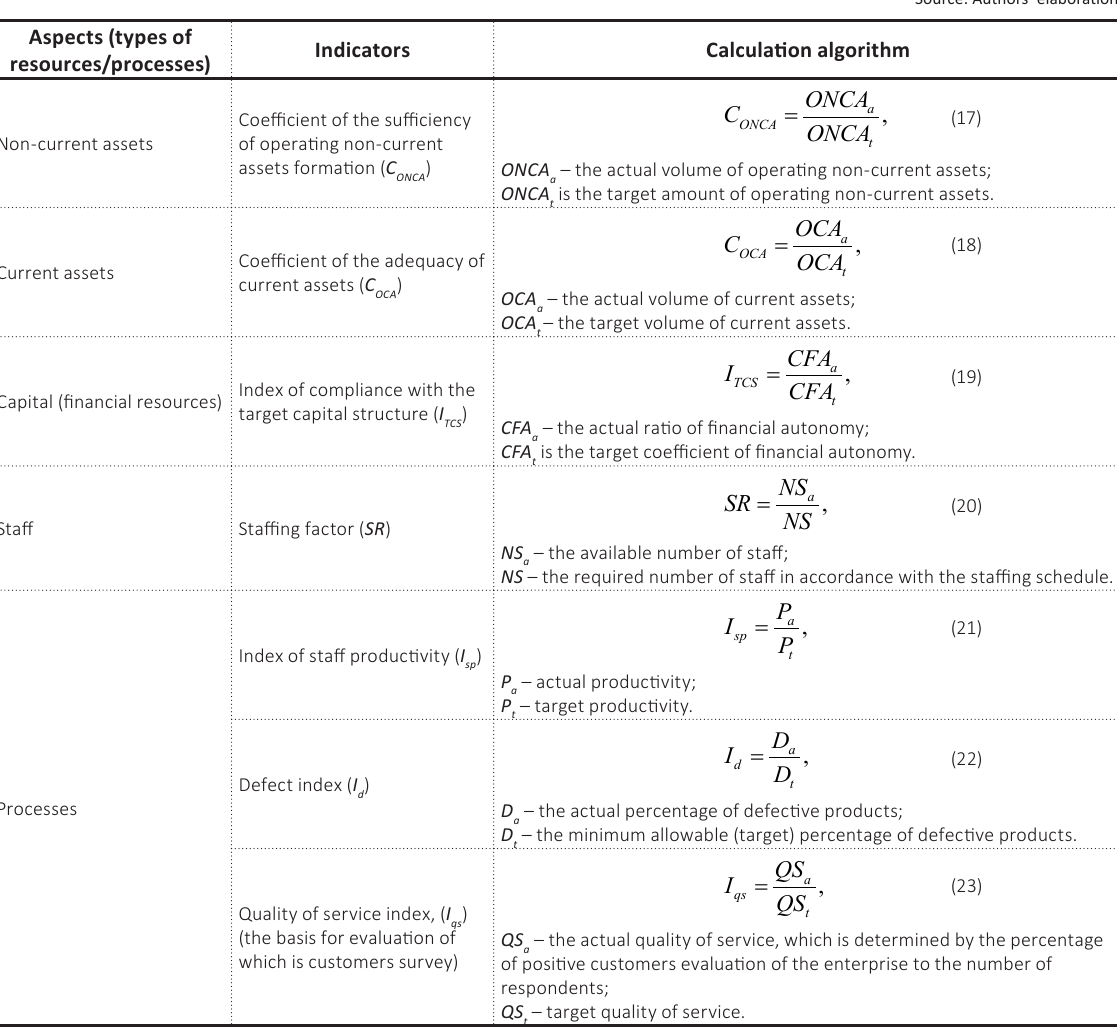
Table 4. Indicators of the enterprise resource and process